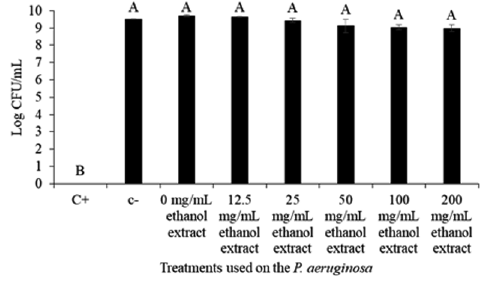
CFU/mL of the P. aeruginosa ATCC 35554 Fig. 1. Log 10 growth against treatment with positive control (C+) 10 mg/mL Chlorhexidine, negative control (C-) DMSO, and C. xanthorrhiza Roxb. extract concentration (0- 200 mg/mL). The alphabetical grouping represent the significance different between extract concentration (Those that share similar letter is not significant different).